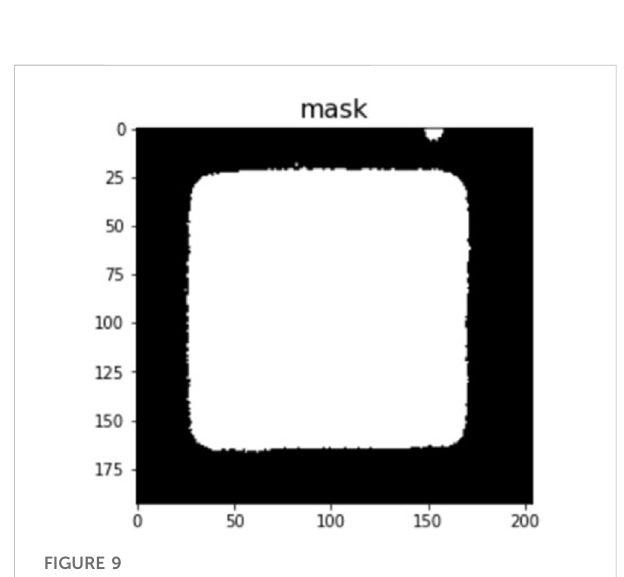
Figure 2E is the CLC chip in an environment of a PBS solution containing 0.001 μ g/mL Anti-Sp and 1 μ g/mL Sp which shows the FC state. According to the above optical image data, the CLCs